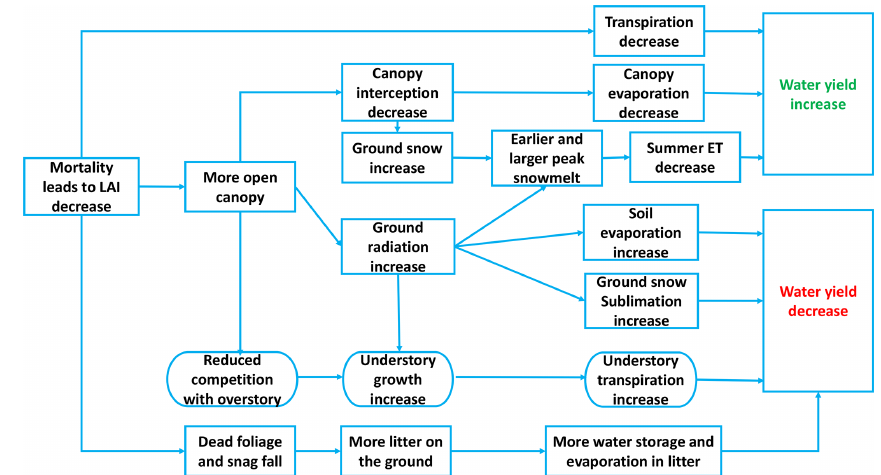
Figure 1. Mechanism of water yield responses to beetle-caused mortality during the red and gray phases (0–10 years after beetle outbreak); semicircular boxes represent understory responses and square boxes represent overstory